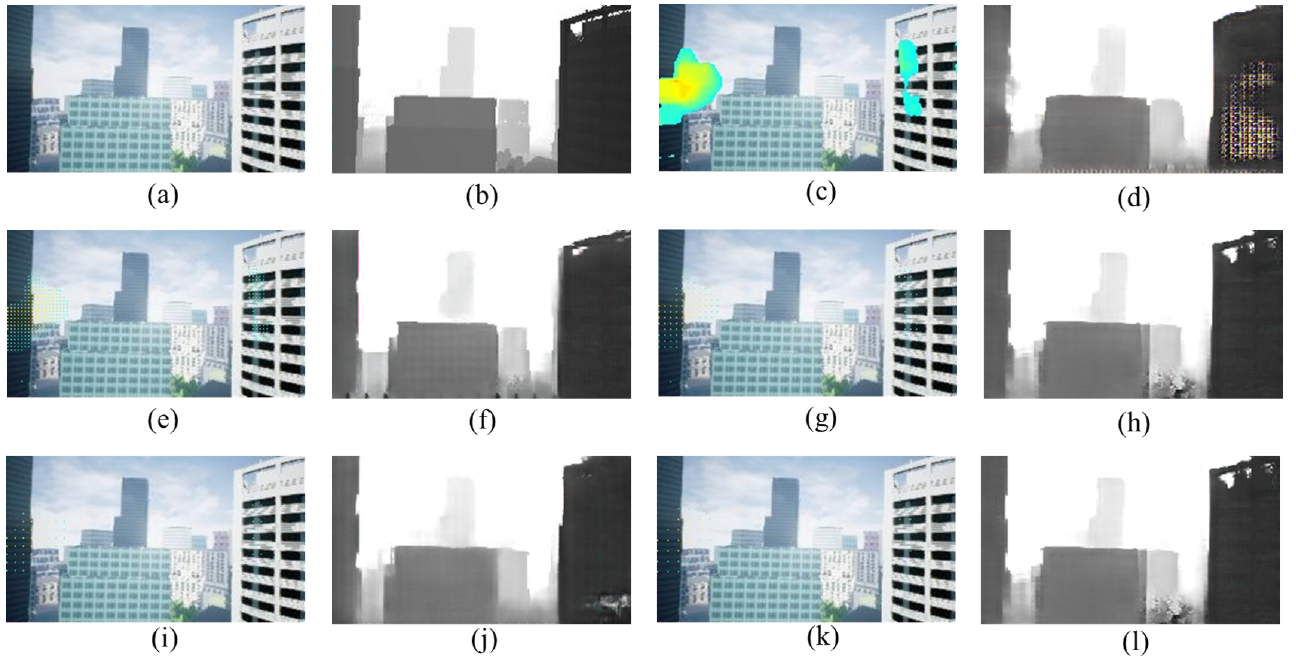
Figure 12. Inputs and outputs of each model: ( a ) RGB image, ( b ) Ground truth, ( c ) One pixels interval model input, ( d ) One pixels interval model output, ( e ) Three Pixels interval model input, ( f ) Three pixels interval model output, ( g ) Five pixels interval model input, ( h ) Five pixels interval model output, ( i ) Seven pixels interval model input, ( j ) Seven pixels interval model output, ( k ) Nine pixels interval model input, ( l ) Nine pixels interval model